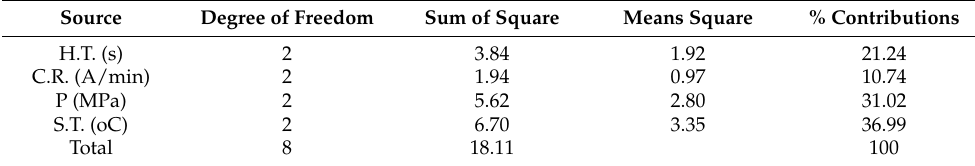
Table 11. ANOVA FOR Mr ⊥